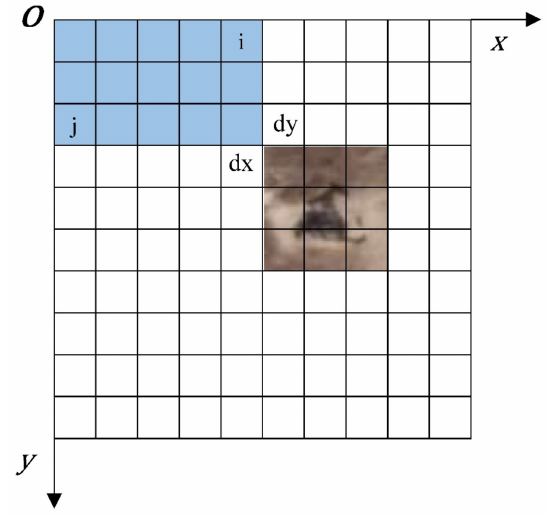
Figure 13. Coordinate system of a remote sensing